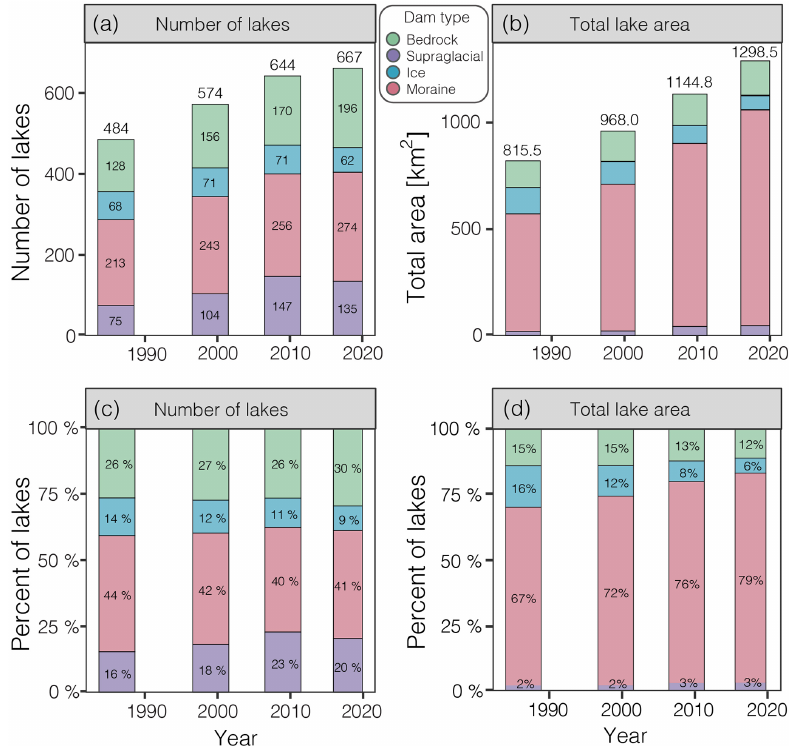
Figure 4. Time evolution of ice-marginal lakes in terms of (a) unscaled number of lakes, (b) unscaled lake area, (c) number of lakes scaled by total number of lakes in that time step (percent), and (d) lake area scaled by the total lake area in that time step (percent). Lakes are colored by lake dam type (legend between panels a and b ). Bar widths correspond to imagery time intervals.